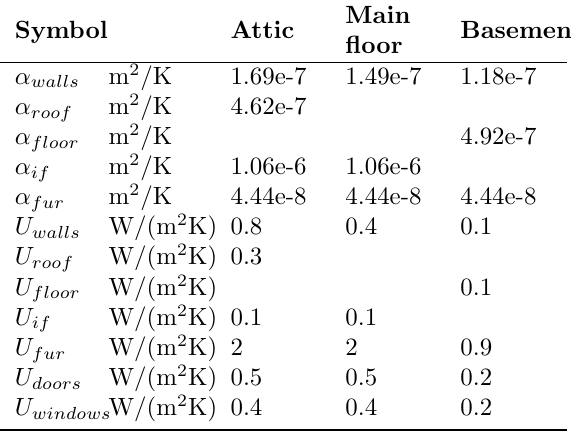
Table 3: Parameter specification for multi-floor model Symbol Attic